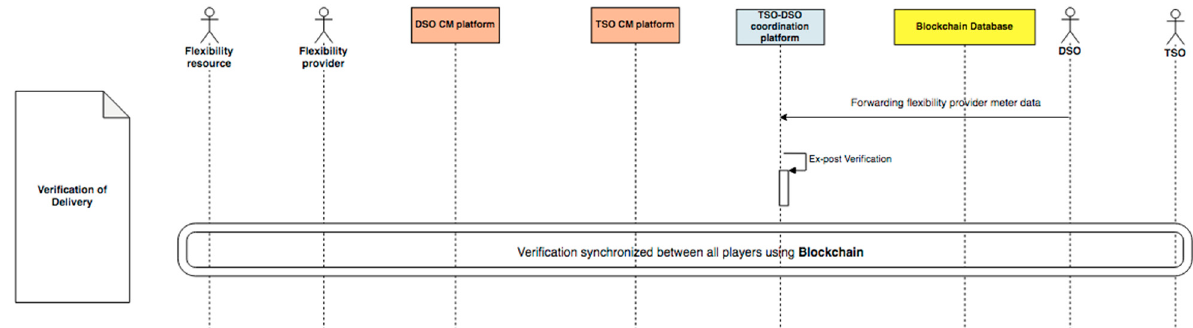
Figure 15. Verification of delivery.